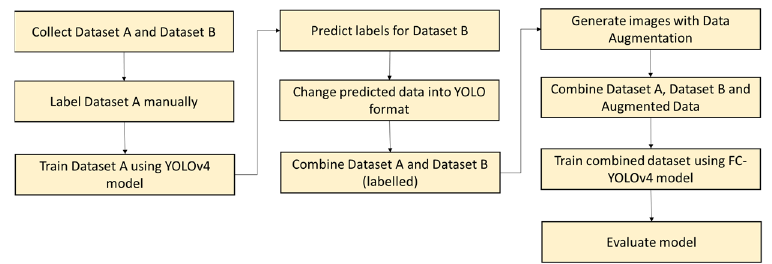
Figure 7. Research Methodology.